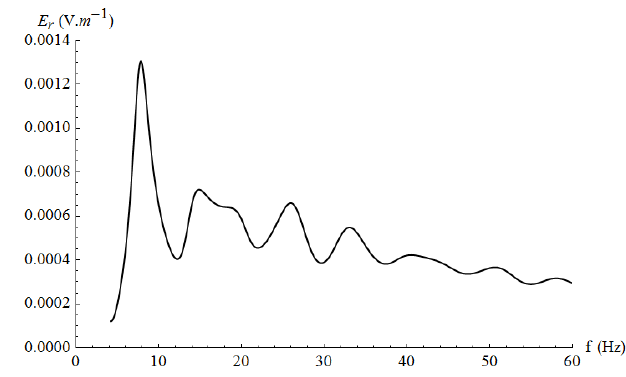
Figure 11: Current moment of red sprite with time.